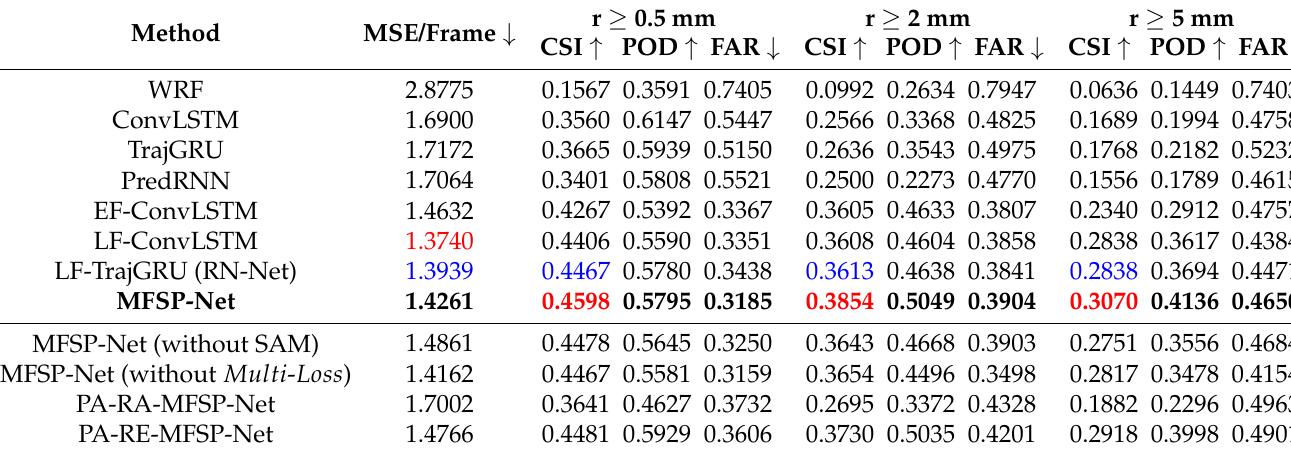
Table 5. Average evaluation results of two frames of precipitation amount nowcasting in the first two hours